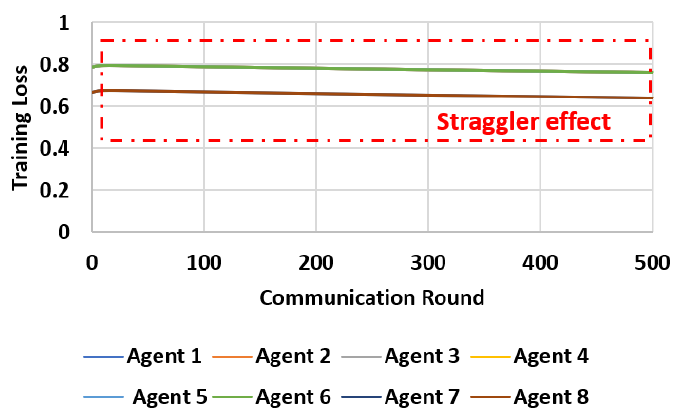
Figure 7. Straggler effects on participating FL agents’ (eight agents and six stragglers) model loss for the prediction of critical infrastructure outage.